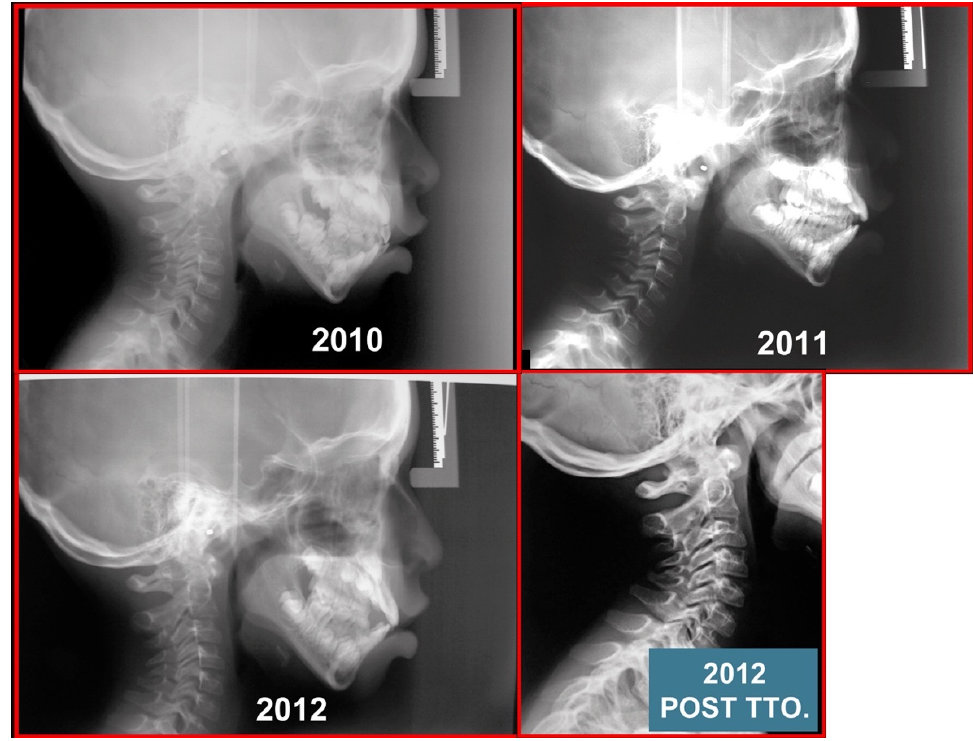
Figure 8. Pediatric patient with otalgia, headache, and facial pain of the occiput. Atlas - axis syndrome previously not diagnosed. A series of lateral cephalograms showing the treatment progress. There is the importance of the neurological connection between the cervical spine and craniofacial and craniomandibular systems.